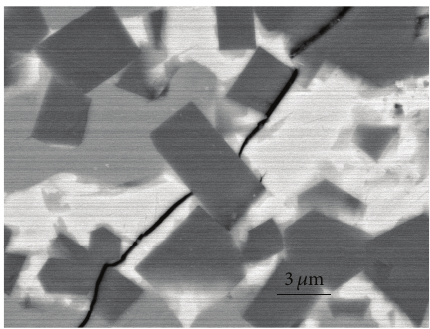
Figure 4: FESEM fracture morphology of TiC-TiB 2 ceramic com- posites.